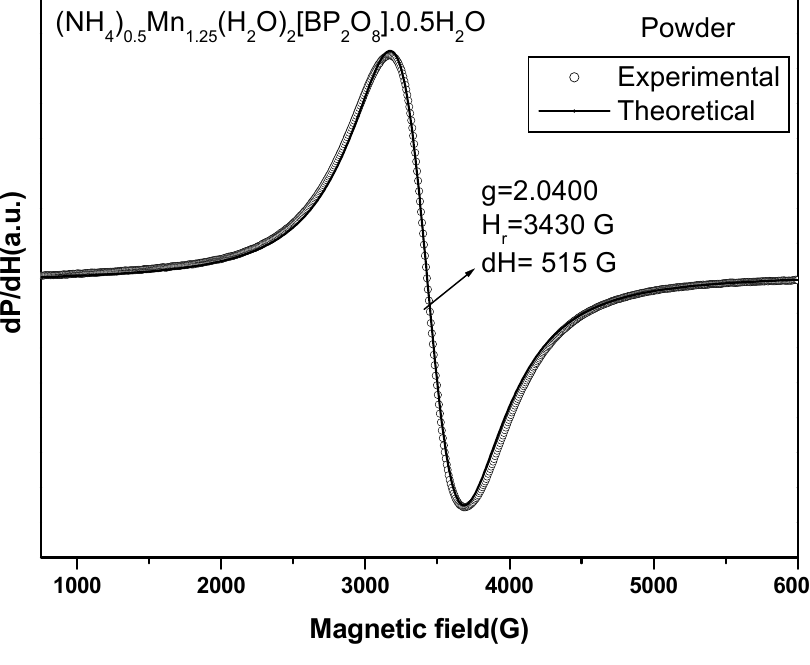
Fig. 5 X-band EPR spectra and its theoretical simulation by using Win-EPR